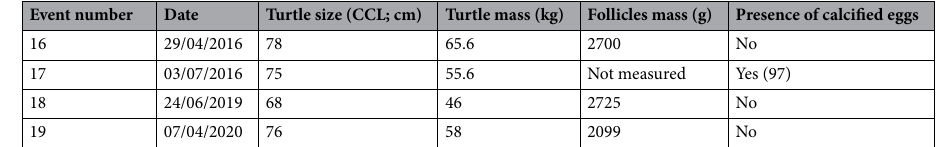
Table 2. Discovery dates (dd/mm/yyyy) and biometric measurements of the four gravid turtles stranded in 2016, 2019 and 2020. For each individual, the weight of follicles measured during the necropsy and the number of calcified eggs are indicated. Event numbers refer to stranding locations and necropsy photos represented on Fig. 5 and Supplementary Fig. S1,